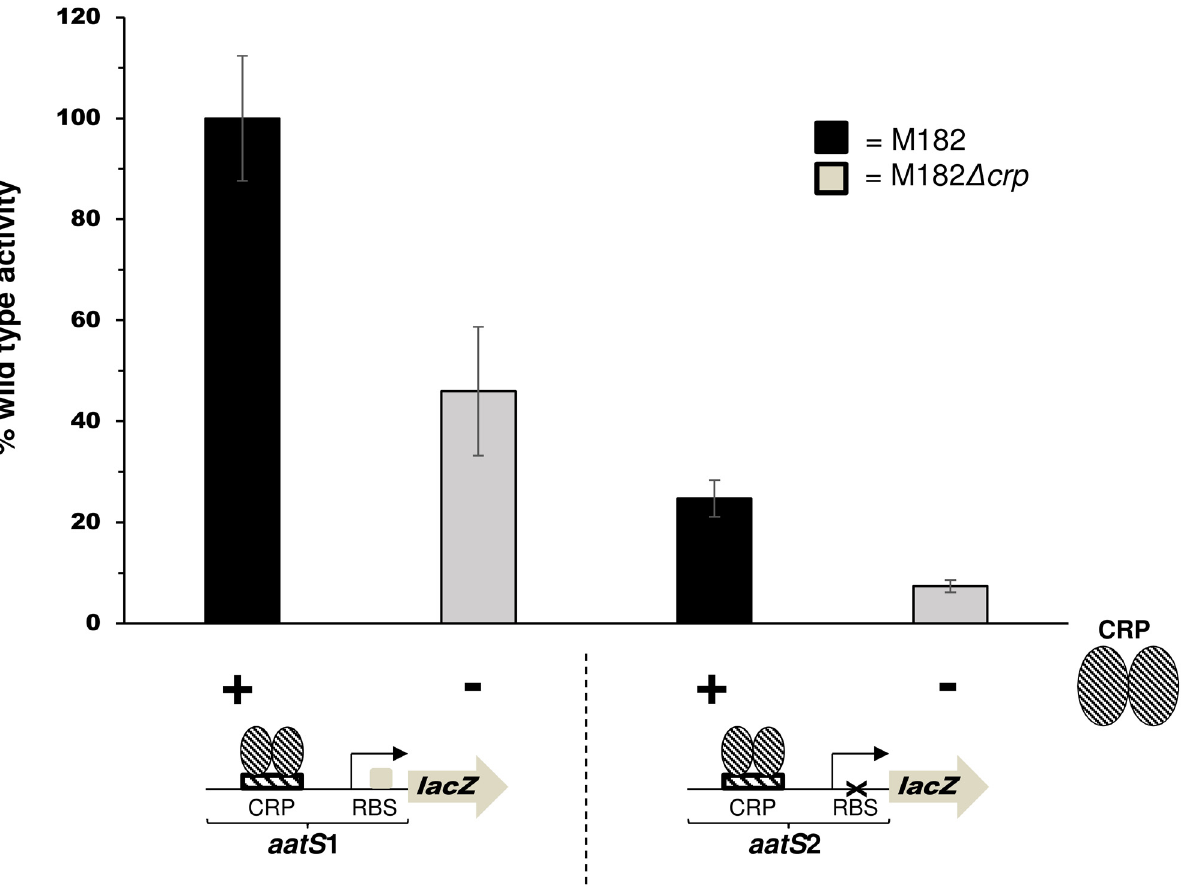
Fig 4. The aatS mRNA contains a functional ribosome binding site. The graph shows activity of different aatS : lacZ translational fusions. The wildtype ribosome binding site (5'-AAGAAG-3') in the aatS 1 fragment was mutated to (5'-TTCTTC-3') in aatS 2. LacZ activites was determined using the lysates of stationary phase M182 or M182 Δ crp . In M182 cells crp was supplied in trans by plasmid pCRP that encodes crp under the control of its own promoter. Values shown are percentages of activity observed in strain M182 (5 Miller units). We obtained 0.25 and 0.26 Miller units of activity from lysates of M182 or M182 Δ crp , carrying promoterless pRW225, respectively. Error bars represent the standard deviation of three independent experiments.